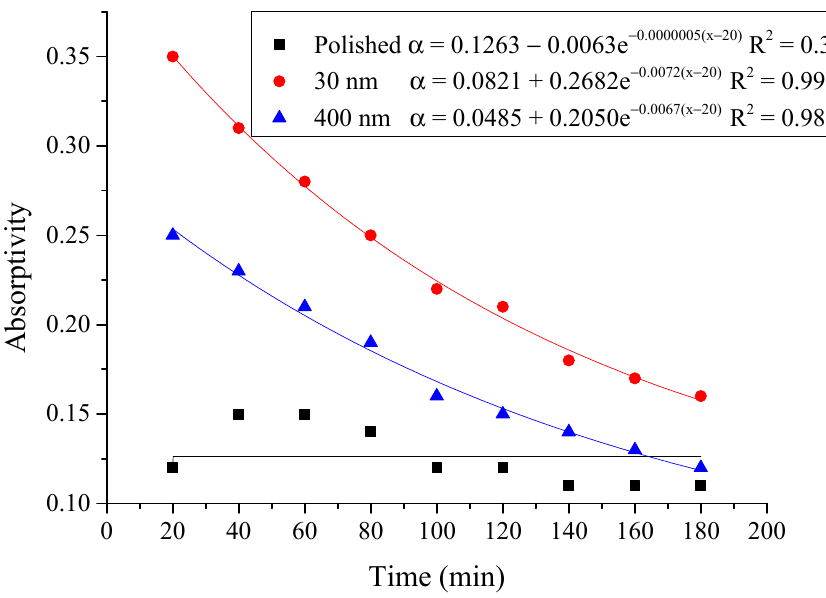
Figure 18. Variation of the average absorptivity for the testing rigs operated under the simulated radiation of 500 W/m 2 .